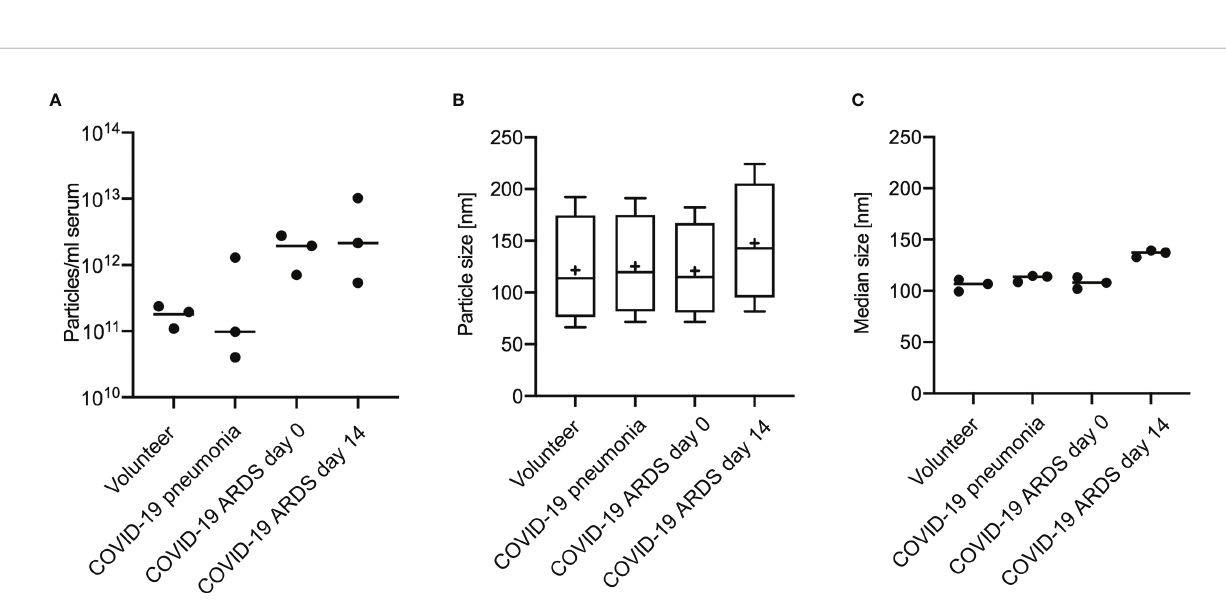
FIGURE 3 | Analysis of extracellular vesicles by Nanoparticle Tracking Analysis shows the distribution of particle number (A) , particle size (B) and median particle size (C) according to subgroups in 3 individuals of each group. Plot A and B: Line = mean value, dot = modal value. Blot B: Boxplots, line=median, += modal value, Whiskers =